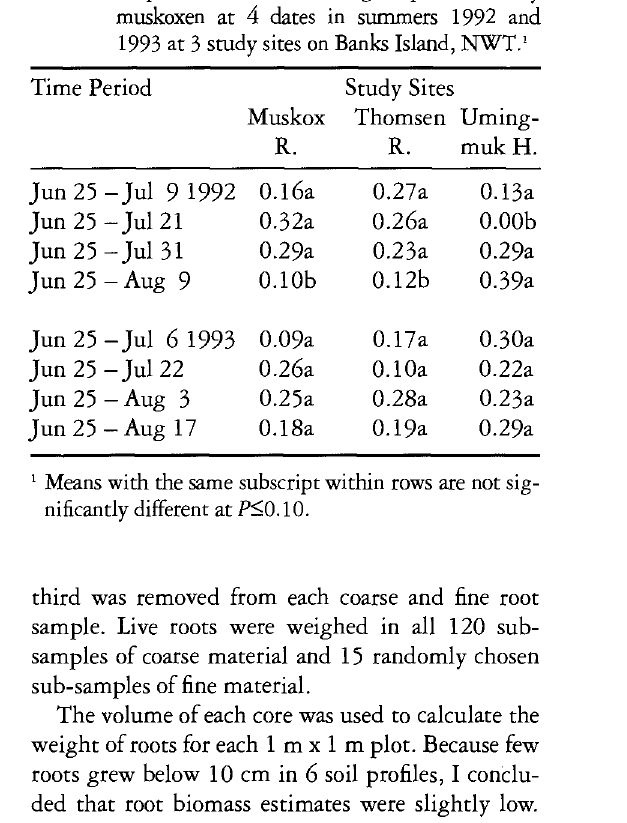
Table 1. Proportions of the standing crop removed